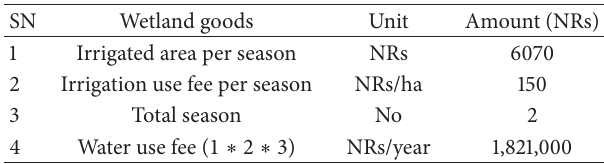
Table 8: Value of water